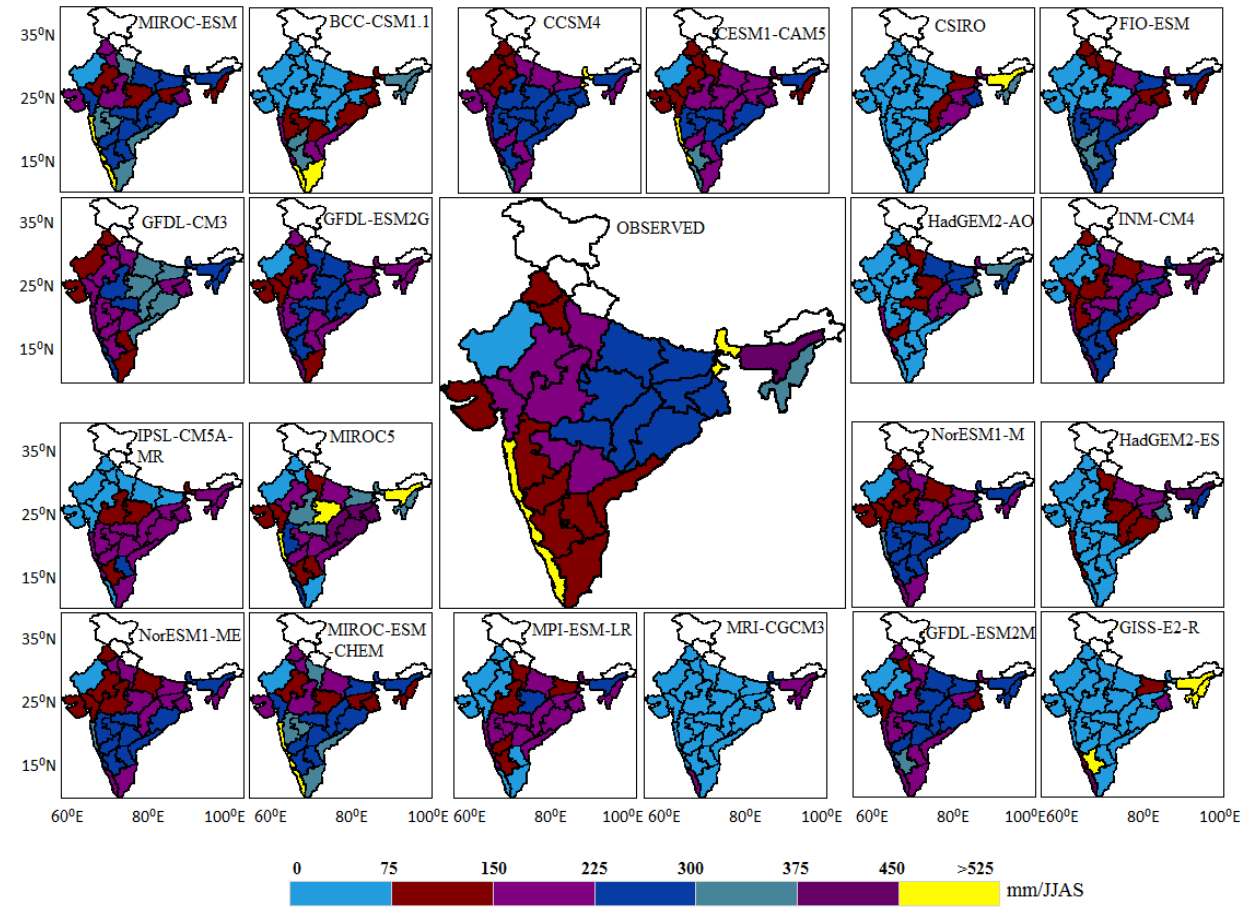
Figure 6. Spatial patterns of JJAS mean rainfall across meteorological subdivisions of India over the time period